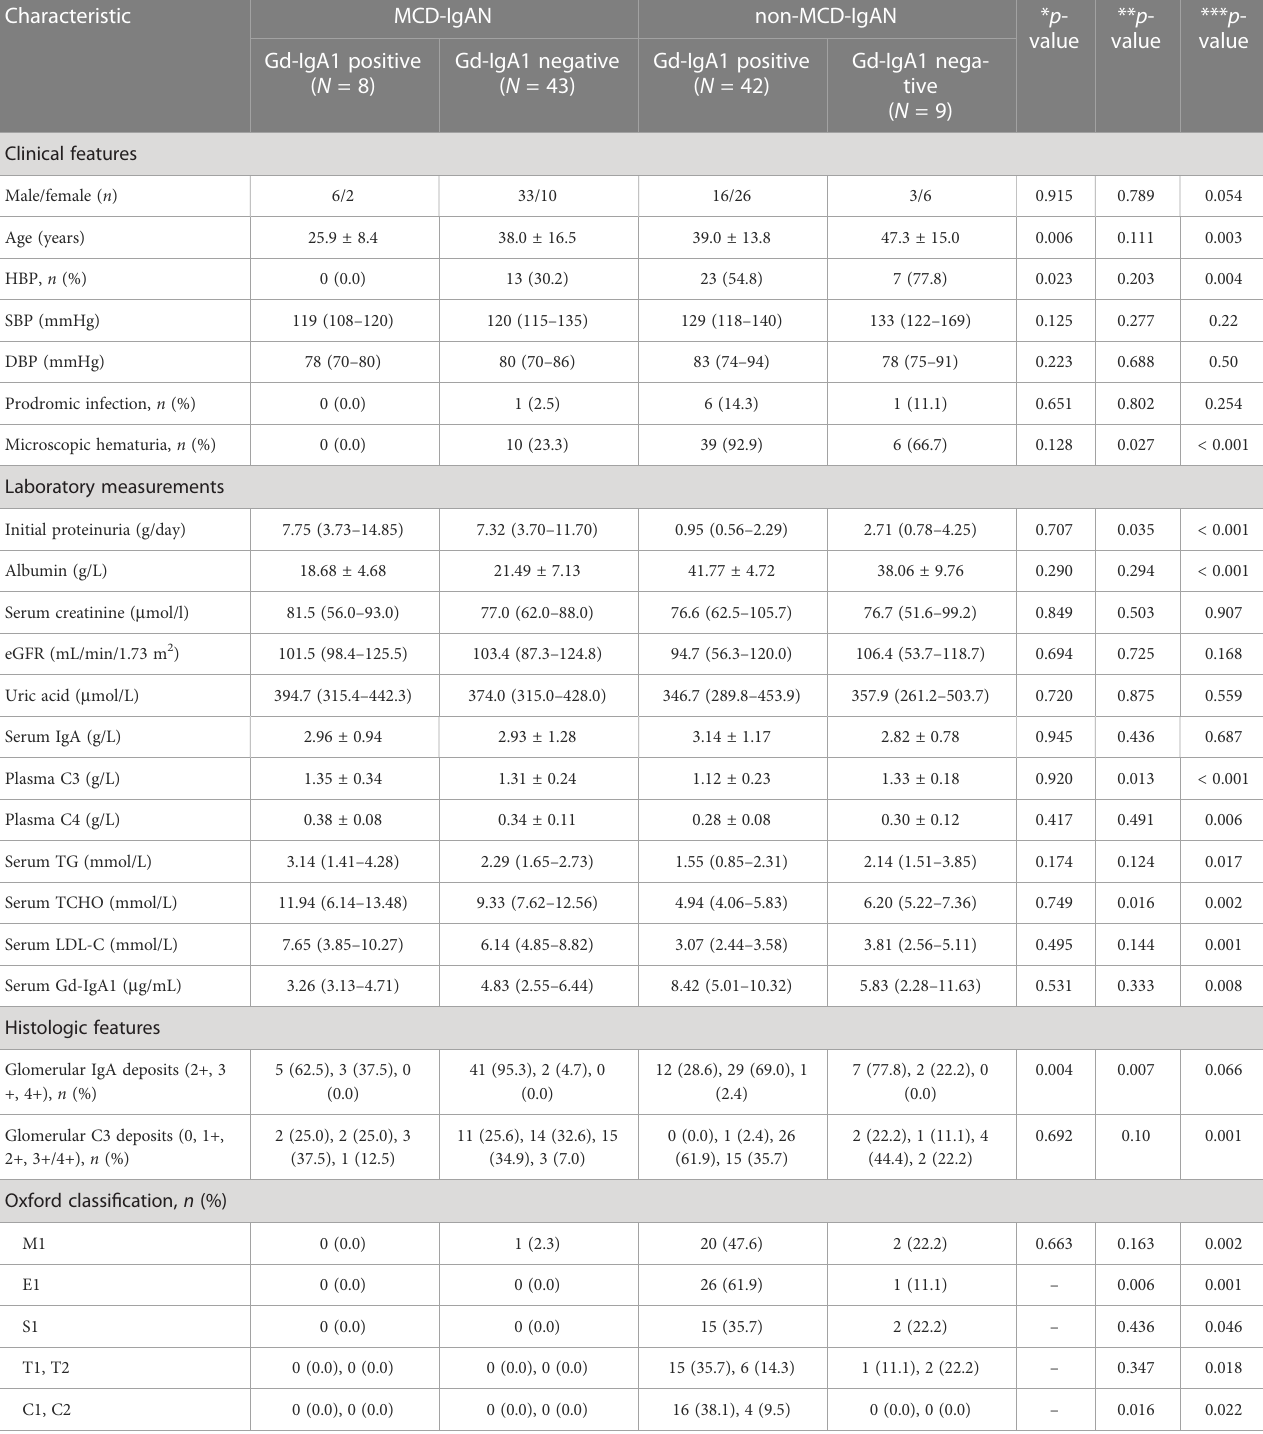
TABLE 2 Demographic, clinical, and histologic characteristics of patients with immunoglobulin A nephropathy based on the staining of galactose- de fi cient immunoglobulin A1 in renal tissues.